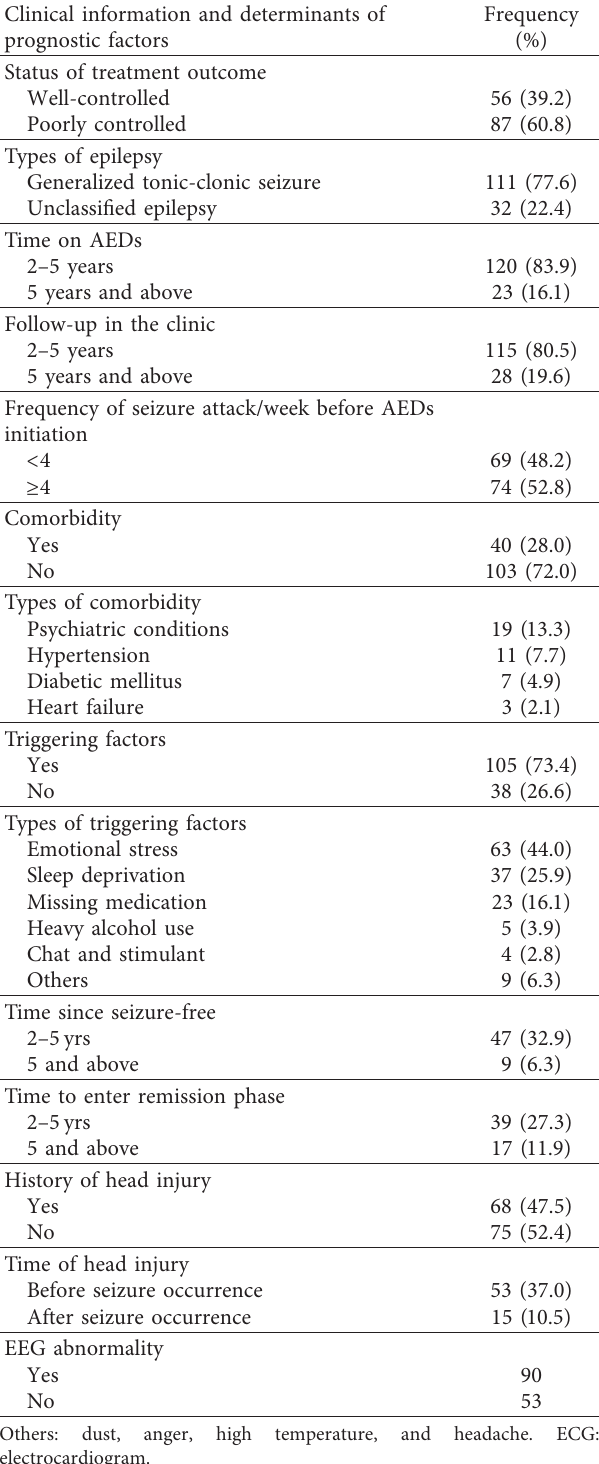
Table 2: Clinical information and seizure treatment outcome among epileptic patients on AEDs at MTUTH from March 10 to April 10,